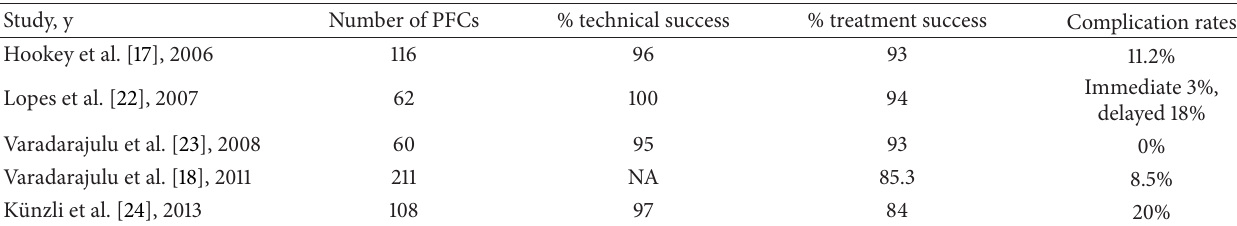
Table 6: Results of EUS-guided drainage from large